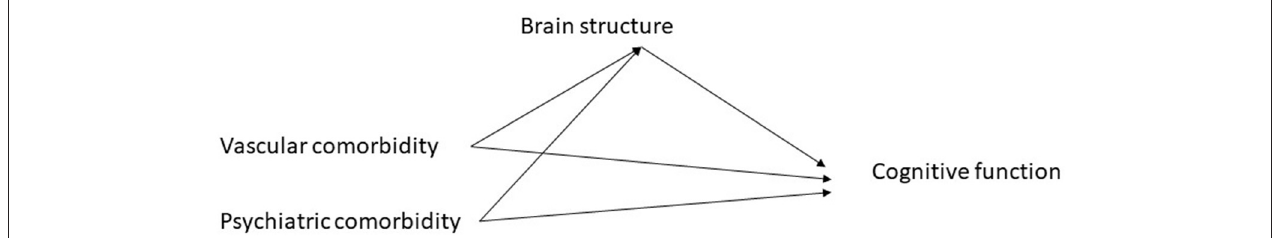
FIGURE 1 | Hypothesized pathways between comorbidity and cognitive